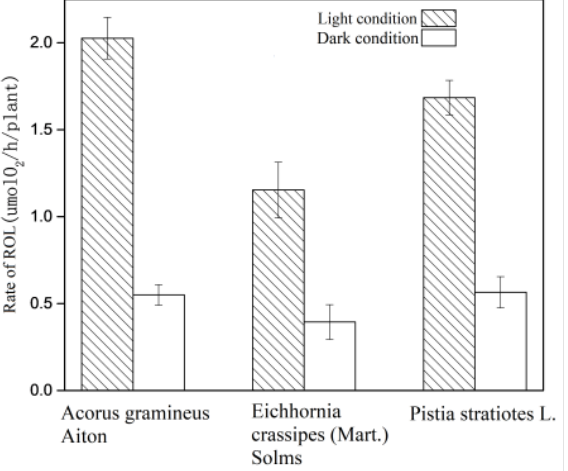
Figure 4. Root oxygen secretion rate of different wetland vegetation.